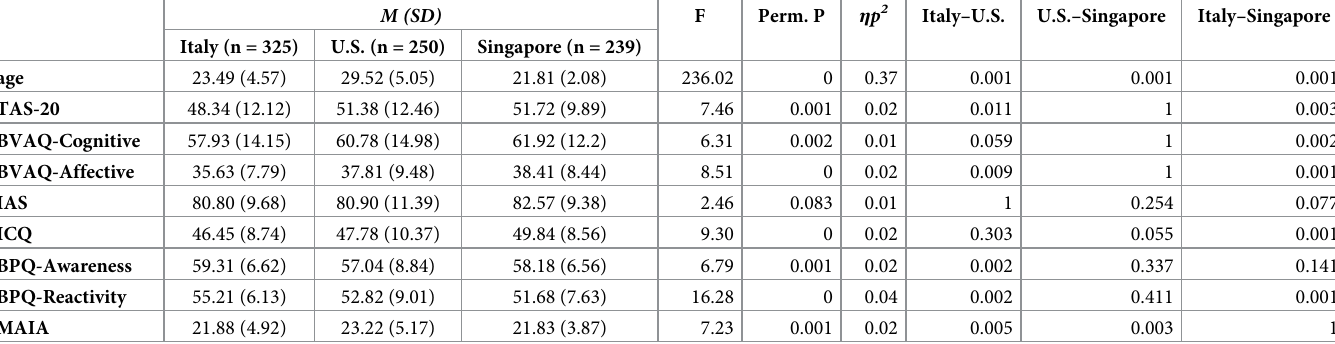
Table 2. Mean (standard deviation in parentheses) values of age and psychological measures for the Italian, U.S., and Singaporean sample. M (SD) F Perm. P η p 2